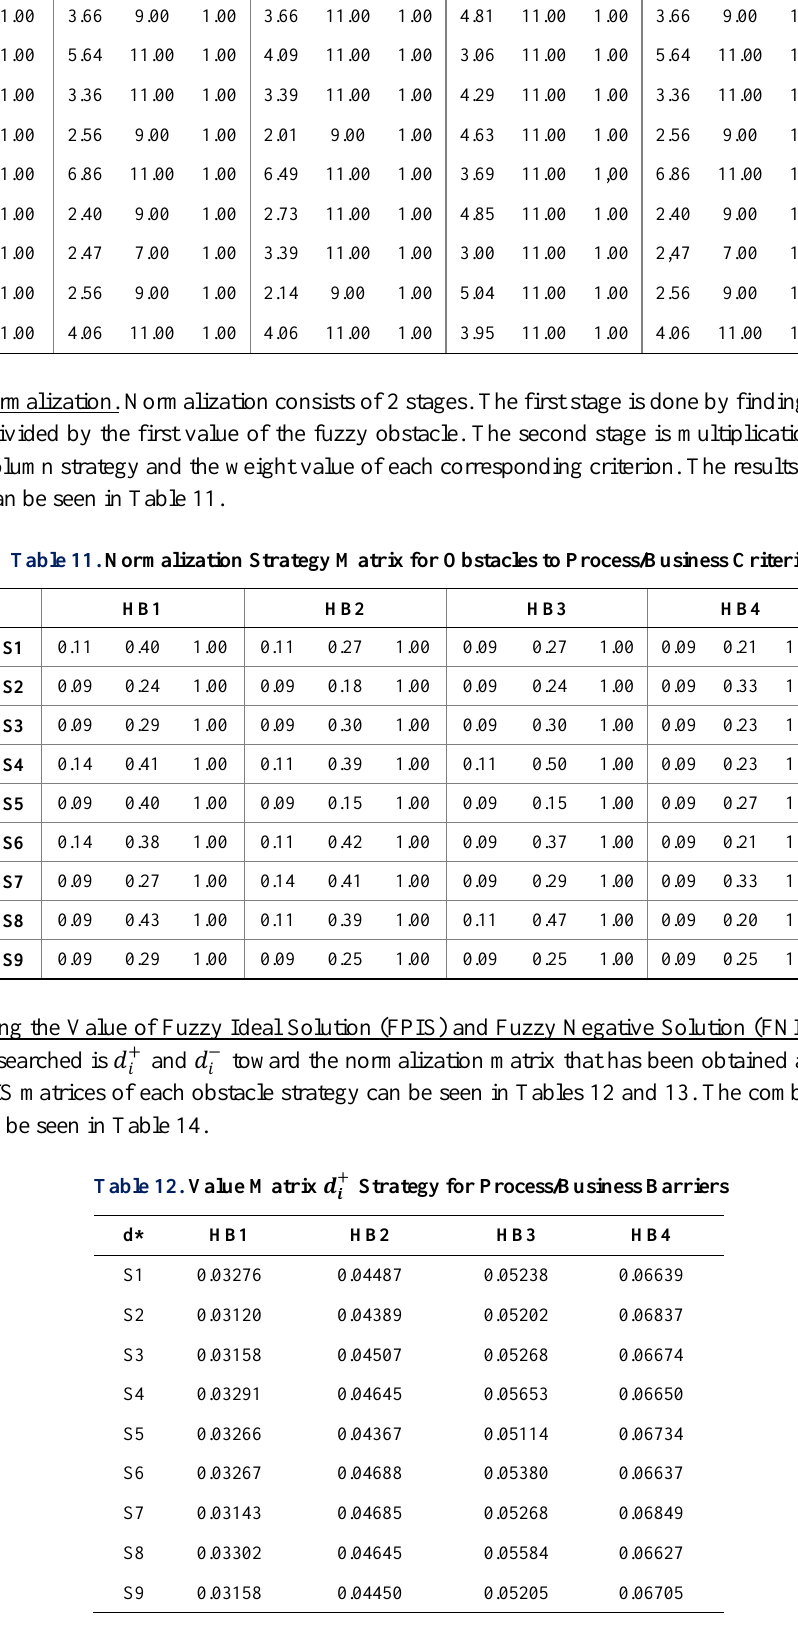
Table 10. Strategy Representative Matrix for Barriers in Process/Business Criteria H2 HB3 HB4 H2 1.00